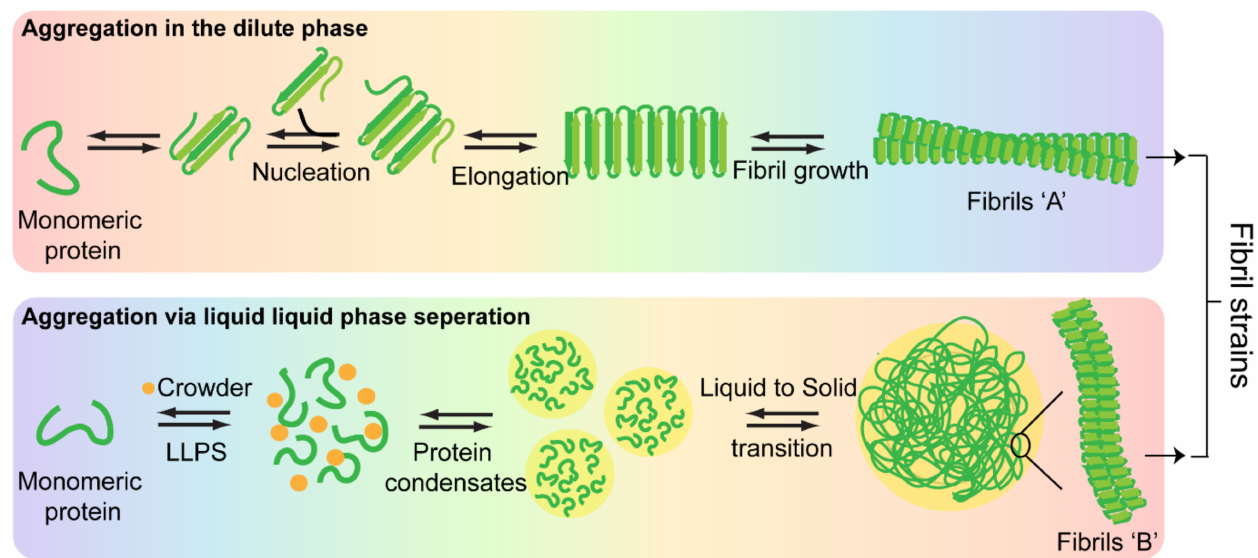
Figure 6. Strain formation under phase-separating and non-phase-separating conditions. Aggregation in the dilute phase involves primary and secondary nucleation events [189], with subsequent growth of nucleating seeds by the addition of monomers to the growing ends or via surface catalysis and maturation into fibrils ‘A’. Alternatively, fibril formation may also occur by liquid–liquid phase separation of the protein into dense liquid condensates facilitated by an increase in the local concentration of proteins in the presence of a crowder [325–328]. This phenomenon results in liquid to solid transition, eventually forming a hydrogel-like state consisting of fibrils ‘B’. Fibrils ‘A’ and fibrils ‘B’, resulting from the aggregation of the same precursor protein but formed under phase separating and non-phase separating conditions, can be different and may represent fibrils